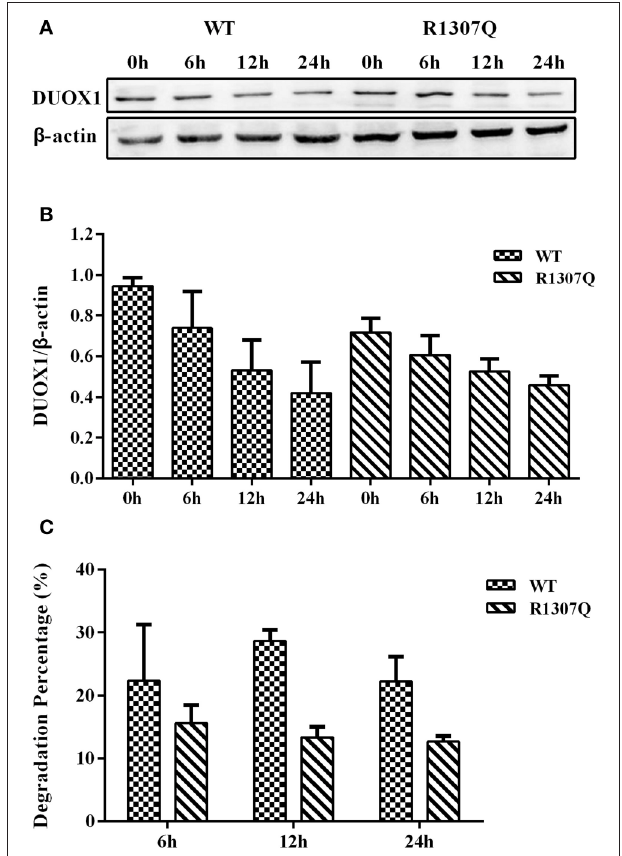
FIGURE 6 | Cycloheximide (CHX) chase study. (A) DUOX1 protein expression was examined at different time periods in cells transfected with WT or p.R1307Q expression vectors. (B) DUOX1 expression was quantified densitometrically as the ratio of DUOX1/ β -actin. (C) Degradation percentage of DUOX1 protein in cells transfected with WT or p.R1307Q expression vectors. Each column represents the mean ± SD of three independent experiments performed in